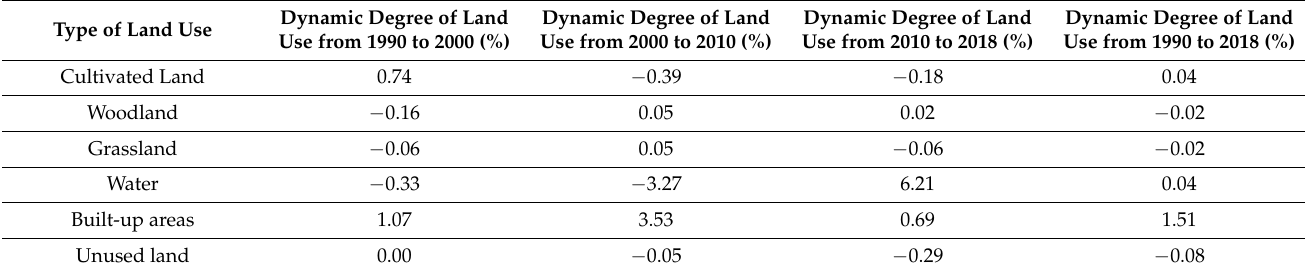
Table 1. Dynamics of different land use in